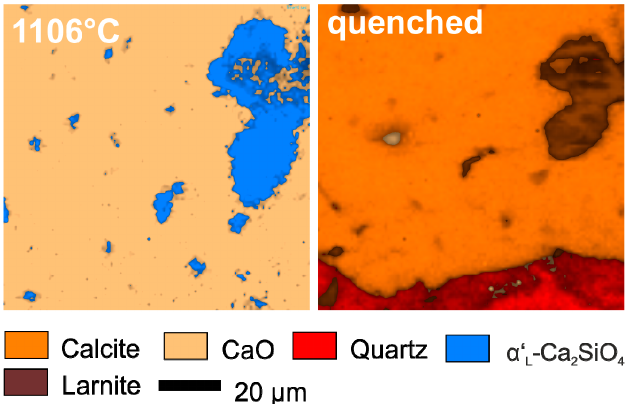
Figure 12. Raman images of a sample composed of quartz and calcite fired to the last temperature step of 1106 ◦ C ( a ) and quenched to RT ( b ). At 1106 ◦ C calcite is decomposed to CaO and CO 2 and quartz completely reacted to α ’ L -Ca 2 SiO 4 (a). After cooling with a cooling rate of 10 ◦ C/min to RT lime has reacted with atmospheric CO 2 to calcite (b). During cooling, α ’ L -Ca 2 SiO 4 has transformed into β -Ca 2 SiO 4 (larnite). Note the slight offset and grain boundary shifts, which is due to differential shrinkage of the sample during